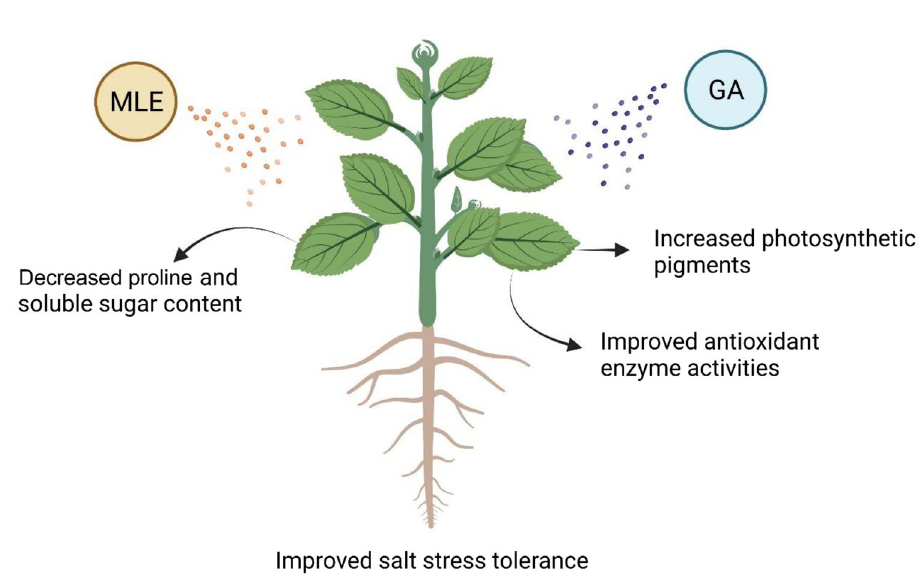
Figure 4. Schematic model figure shows how MLE and GA alleviates salinity stress in Mentha